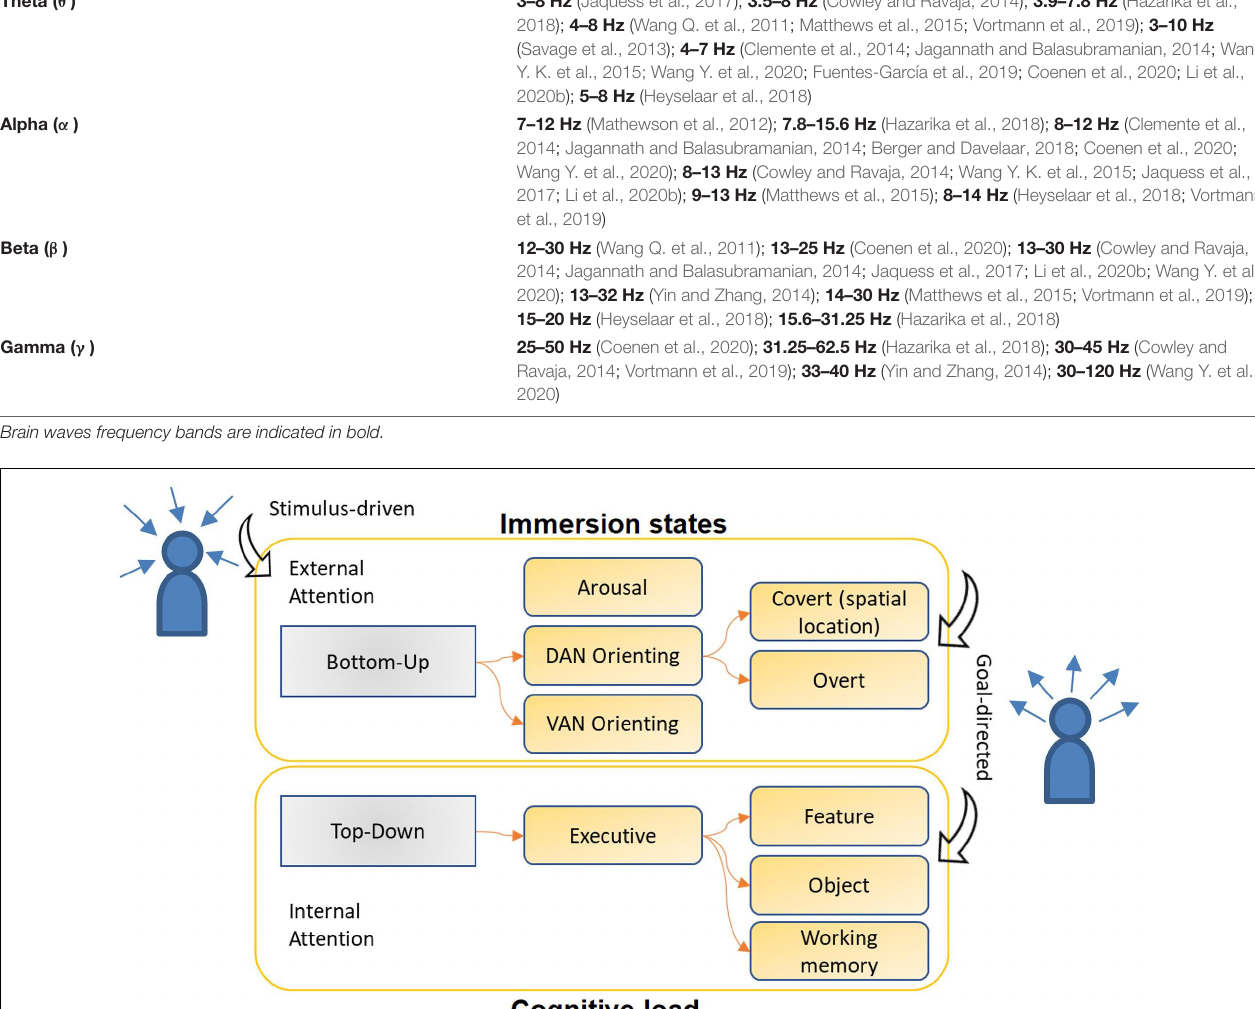
the different conceptualizations discussed, illustrating how they are complementary, sometimes